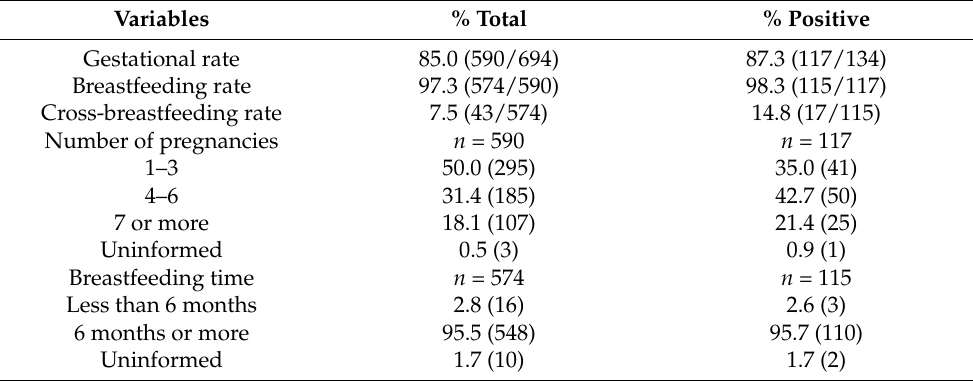
Table 4. Epidemiological characteristics of the women